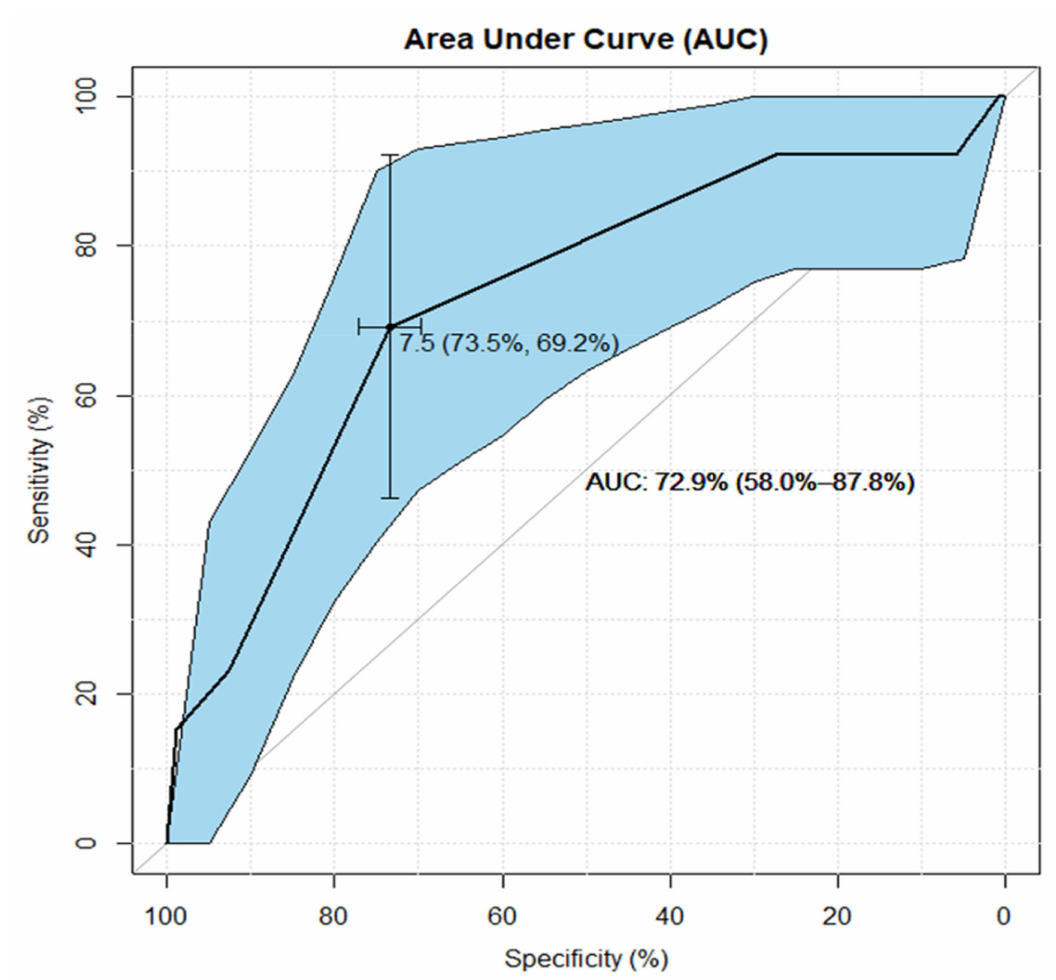
Figure 3. Antero-posterior (AP) dimension in the ROC analysis of the chance for incorrect diagnosis of pituitary lesions in a conventional MRI examination in children with growth or puberty disorders. The receiver operating characteristic (ROC) analysis shows that the antero-posterior (AP) dimension is a statistically significant (area under curve [AUC] lower CI 95% > 50%) predictor of the appropriateness of contrast administration in the diagnosis of pituitary focal lesions in children with growth or puberty disorders (GPDs). Classification of pa-tients based on the AP cut-off = 7.5 mm indicates proper post-contrast diagnosis in (AUC ∼ 73%=) 3 out of 4 patients. Furthermore, ROC analysis of the AP dimension testifies the best fitted combination of sensitivity (69%) and specificity (74%) rates, which reveals the high ability of this predictor to use gadolinium-based contrast agent (GBCA) correctly when required, and the proper omission of GBCA administration when